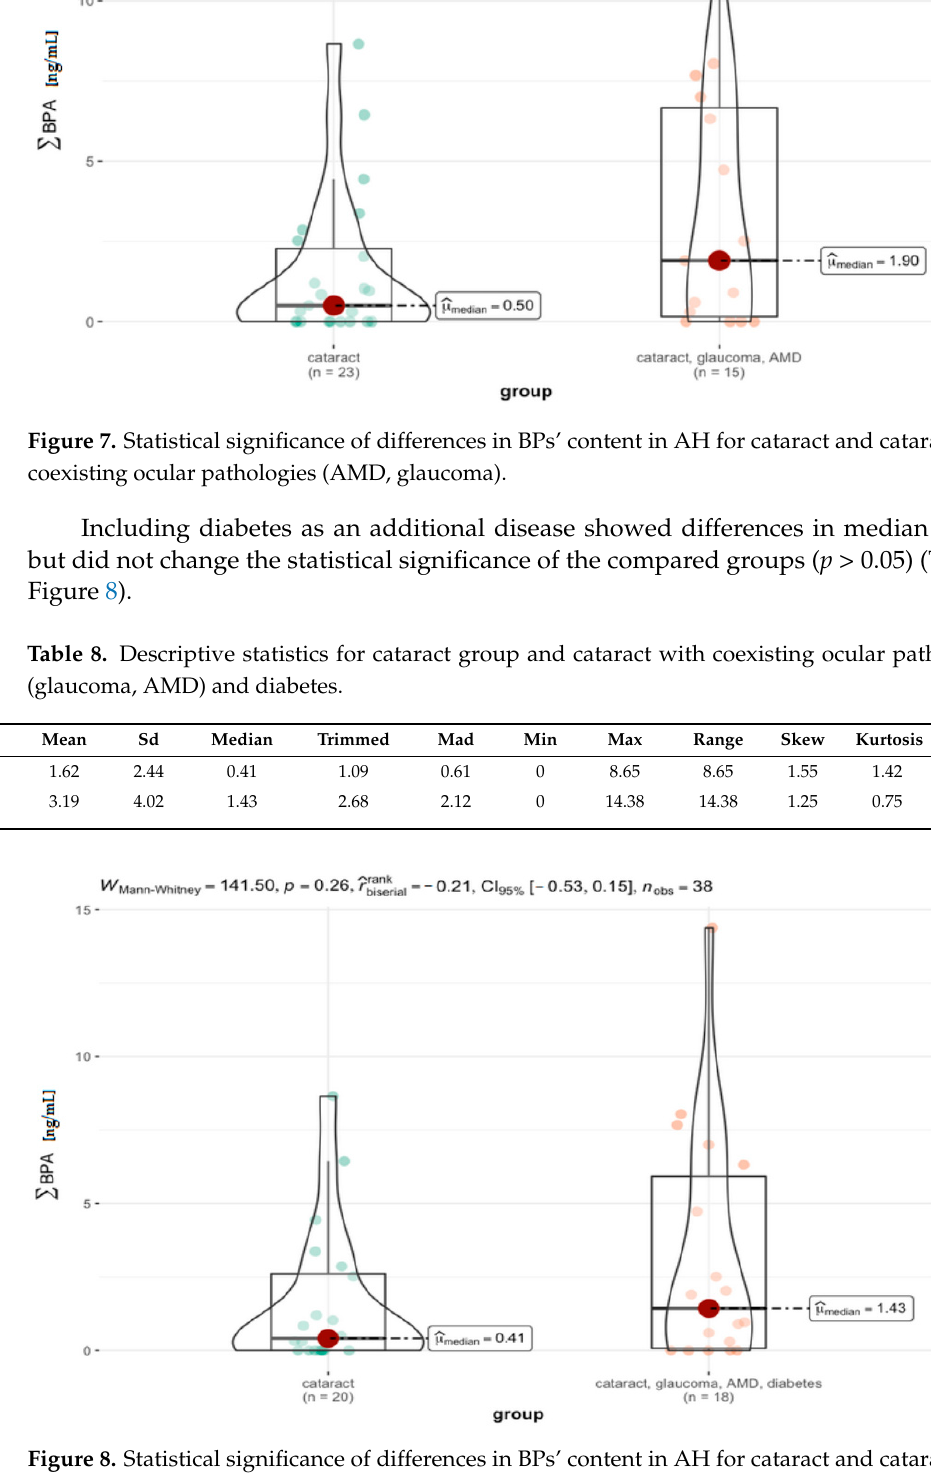
Table 7. Descriptive statistics for cataract group and cataract with coexisting ocular pathologies (glaucoma, AMD) group.